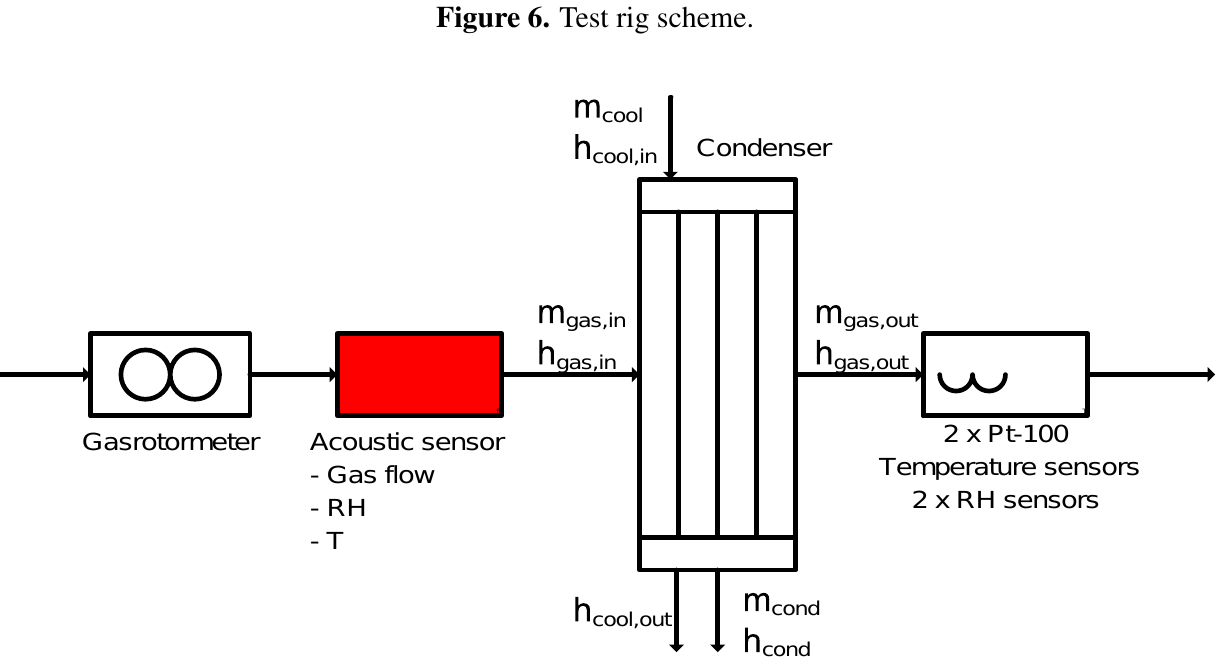
Figure 6. Test rig